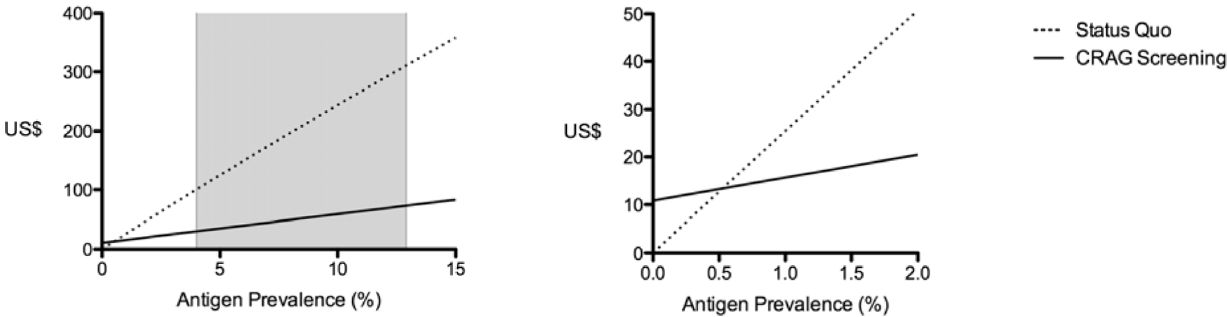
Figure 3. Sensitivity analysis by background antigen prevalence. The results of one-way sensitivity analysis varying the background cryptococcal antigen prevalence in patients entering ART programmes with CD4 cell counts , 100 cells/ m L. The cost of current standard of care (no prevention, or status quo) is shown by the dotted line, and the cost of the CRAG screening with targeted treatment of CRAG positive individuals with high dose fluconazole (no LPs) is shown by the solid line. The screen and treat strategy dominated the standard of care at antigen prevalences of 0.6% and higher. The shaded area represents the range of baseline CRAG prevalence figures reported in patients with CD4 counts , 100 cell/ m L at ART programme entry. Costs are expressed as mean cost per patient/year in the ART